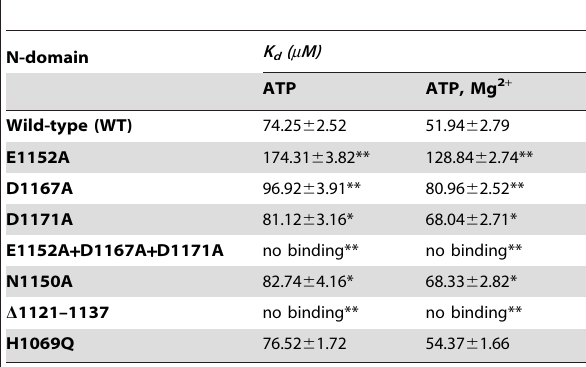
Table 1. Nucleotide binding affinity for the N-domain of Wild Type and mutant proteins.